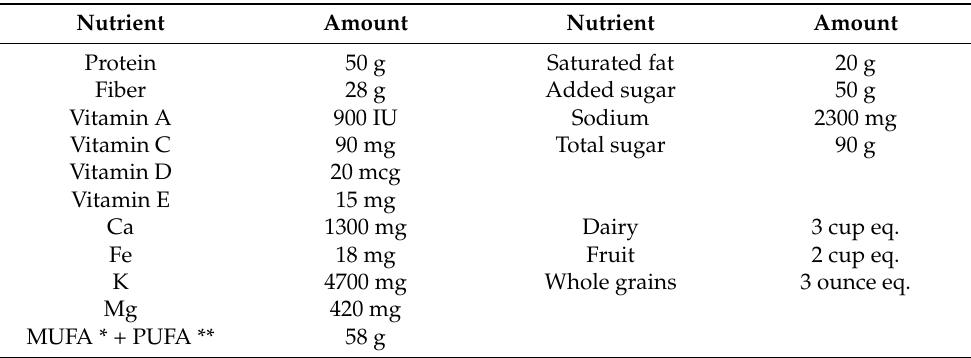
Table 1. Nutrient standards based on Food and Drug Administration values.